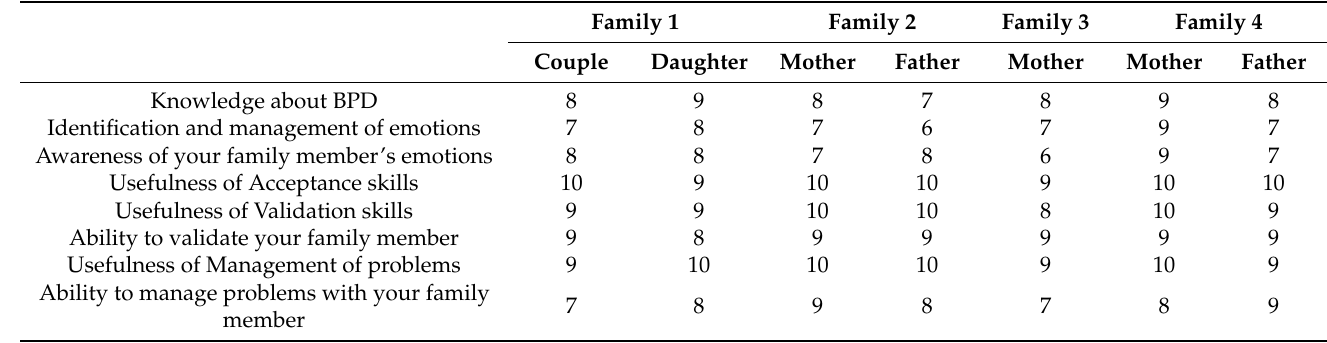
Table 3. Skill scores on the OTSM